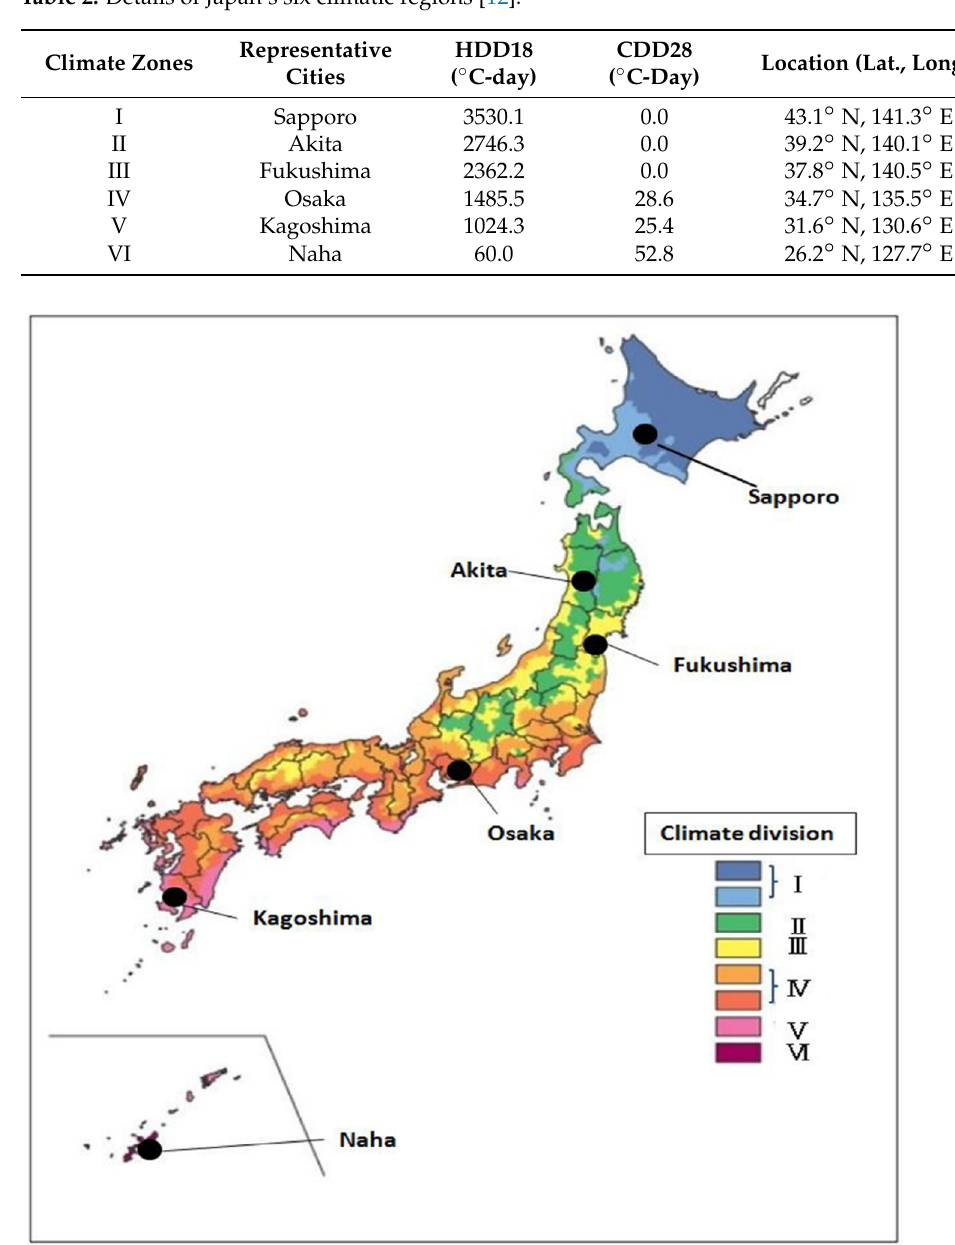
Figure 9. Six climate zones of Japan and representative cities in different climate zones [12].